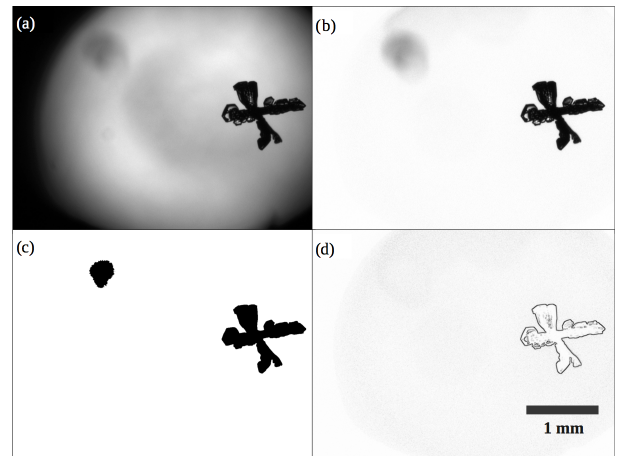
Figure 4. Automated image processing steps shown for an example image. Panel (a) shows the original image; (b) cleaned image (back- ground features removed); (c) binary mask, where logical True val- ues correspond to regions on the cleaned image that are darker than the grey-level threshold, here shown as black; (d) gradient matrix computed from the cleaned image, with values scaled to grey lev- els for representation (largest gradient value corresponds to black and zero gradient to white). See description in text for details of the processing procedure. The resolution is indicated by a size bar of